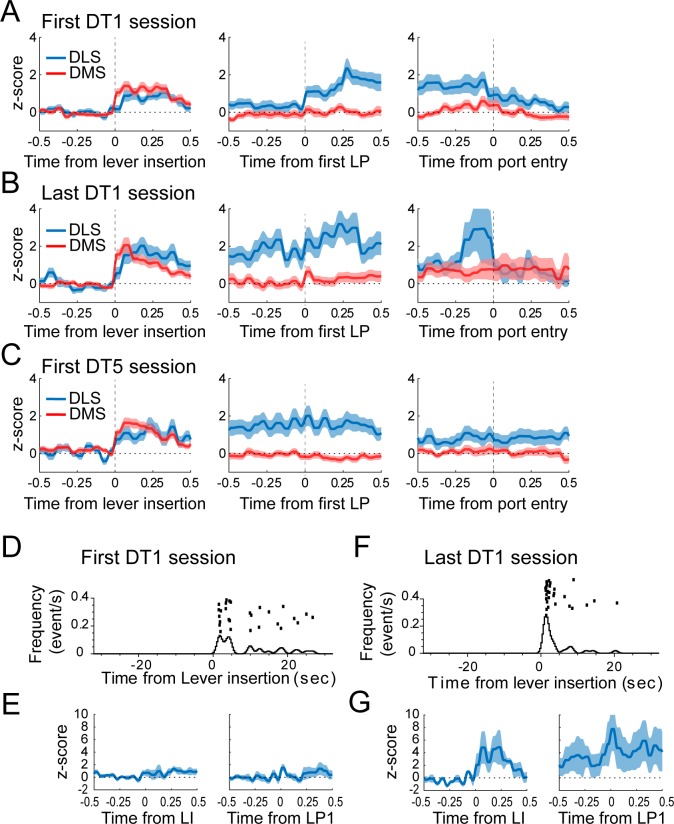
Moderate changes in DLS activity across the first DT1 early training sessions.(A–C) Average z-score (± SEM) of putative-MSNs around the lever insertion (left), the first lever press (middle), and the port entry (right) in DMS and DLS neurons during the first DT1 session (A), the last DT1 session (B), and the first DT5 session (C). DLS activity before the first lever press differs during the first DT1 session compared to the last DT1 session (p<0.05) and the first DT5 session (p<0.05). (D and F) Peri-event raster and histogram of lever presses aligned to the lever insertion (upper part) in the first DT1 session (D) and the last DT1 session (F) of a representative rat. (E and G) Mean z-score (± SEM) around the lever insertion (left) and the first lever press (right) in DLS neurons during the first DT1 session (E) and the last DT1 session (G) depicted in D and F.